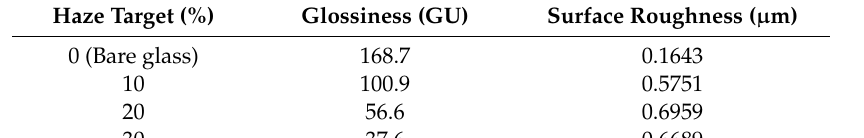
Table 9. Glossiness and surface roughness of the glass substrates with various haze targets.